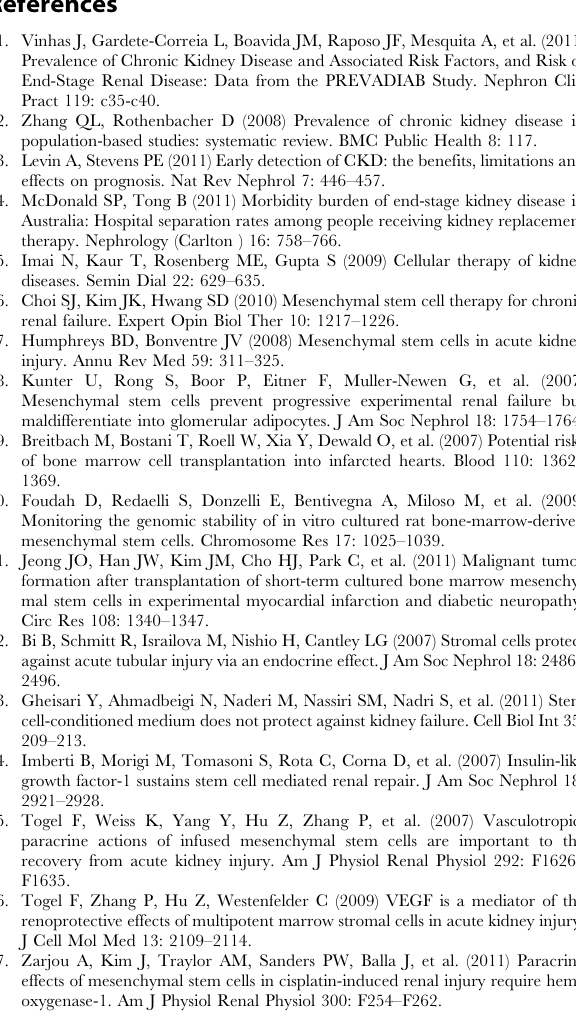
Figure S1 Glomerulosclerosis and tubulo-interstitial damage after exosome treatment. A: Segmental (segm) and total (tot) glomerulosclerosis (GS); B: Tubulo- interstitial damage. Exosomes (n= 8); PBS (n = 7). There were no significant differences. Figure S2 Exosomes stimulates in vitro angiogenesis. Average tube length was increased after exosome treatment compared to PBS. *P , 0.05: exosomes vs. PBS